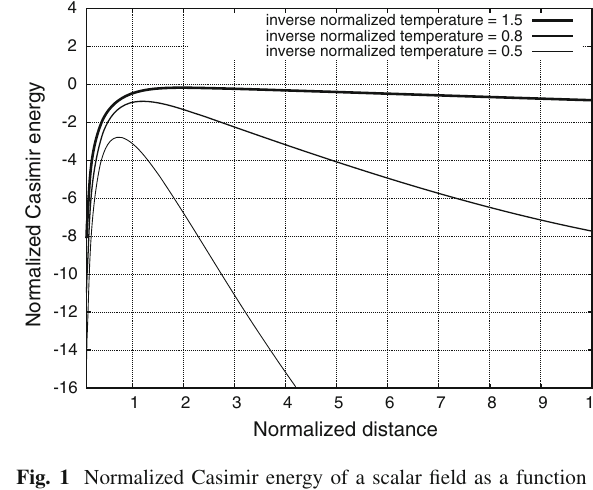
Fig. 1 Normalized Casimir energy of a scalar field as a function of normalized separation for different normalized temperatures. ¯ m is set